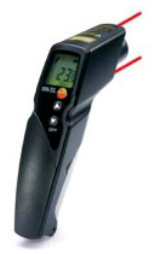
Fig. 1. Škoda Octavia Combi II 2007